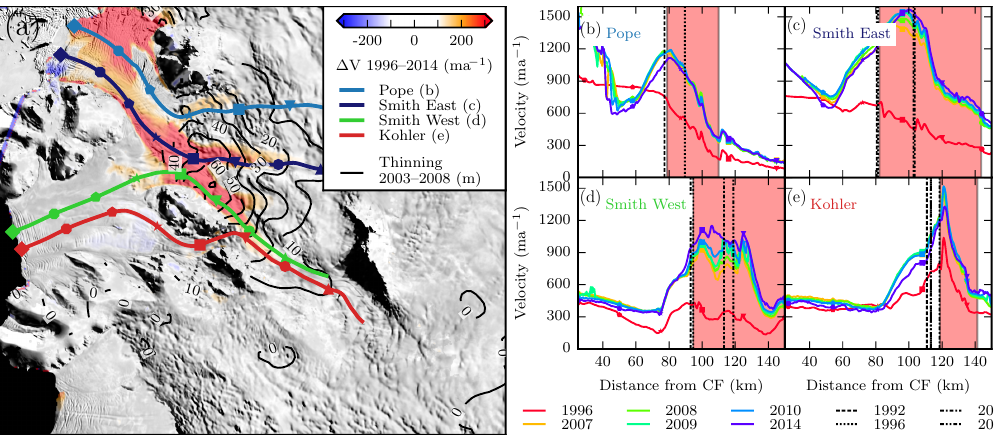
Figure 2. Recent changes in velocity and surface elevation. (a) Color shows change in speed from 1996 to 2014. Contours indicate thinning of grounded ice from 2003 to 2008 at 10m intervals, derived from OIB altimetry, ICESat-1, and WorldView/GeoEye DEMs. Colored lines indicate flow lines plotted in panels (b) – (e) . Background is MOA. (b) – (e) Velocity profiles as distance from the 2014 calving front (CF). Dashed lines indicate grounding-line positions in different years. Red shading indicates areas that thinned by more than 5myr − 1 from 2003 to